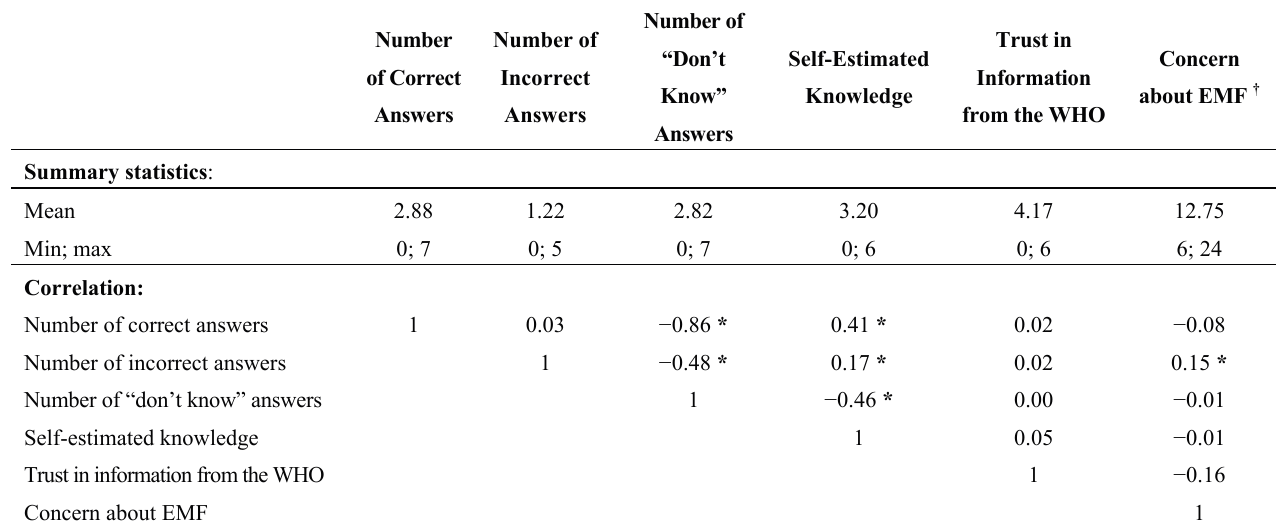
Table 2. Spearman correlation matrix regarding EMF-knowledge of GPs in Germany in 2008.